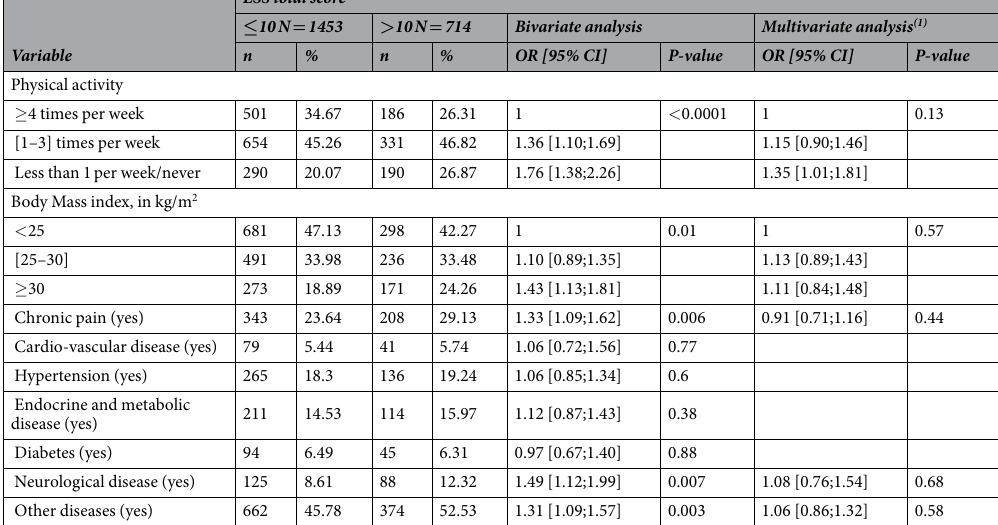
Table 1. Bivariate and common analyses of the association between potential determinants and excessive daytime sleepiness (Epworth Sleepiness Scale (ESS) total score > 10) at baseline. (1) For the multivariate analysis, only gender and variables associated at p < 0.15 in univariate analysis were entered into the